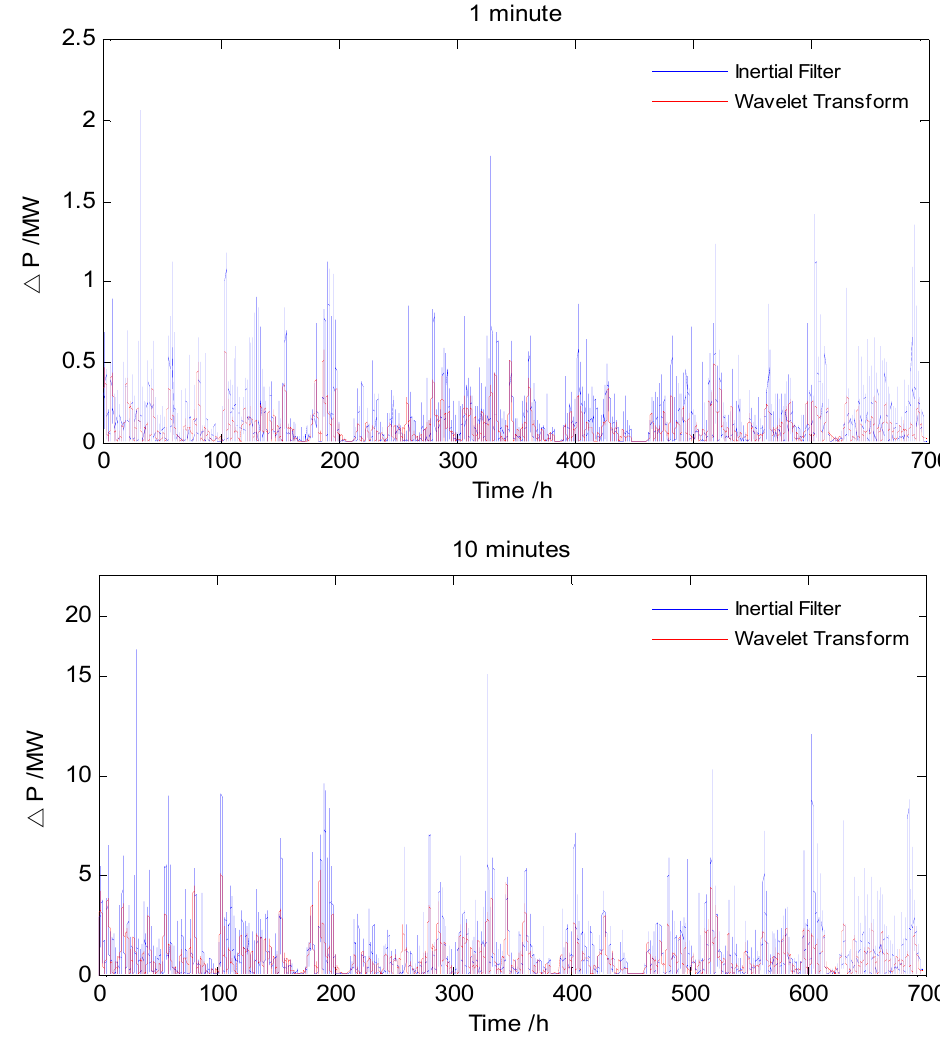
Figure 13. The power variation smoothed by the Inertial Filter and Wavelet Transform in 1 min and 10